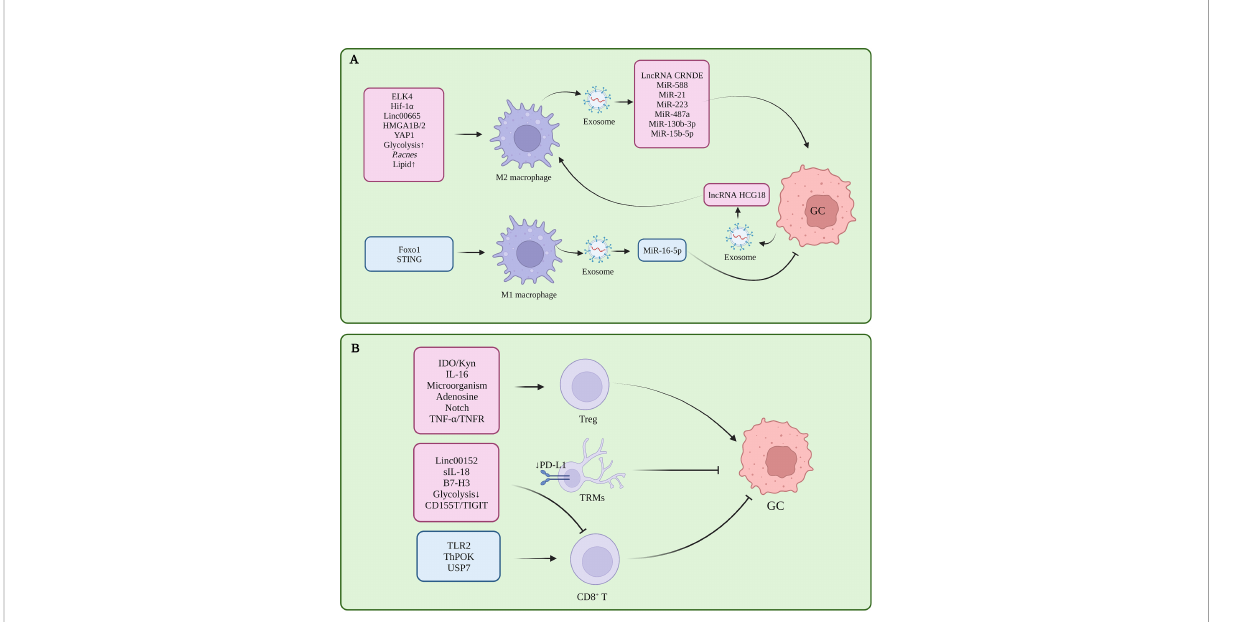
FIGURE 1 (A) Tumor-associated macrophages in gastric cancer immune tolerance. (B) Tumor-in fi ltrating T cells in gastric cancer immune